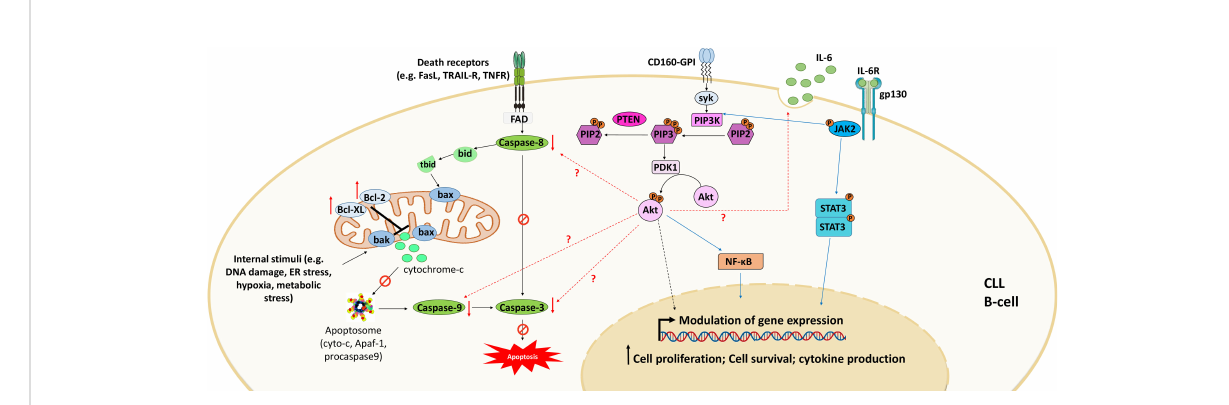
FIGURE 3 CD160 signaling in CLL. Engagement of CD160-GPI via its receptors (MHC-I or HVEM) or monoclonal antibodies leads to activation of the PI3K/ Akt signaling pathway to modulate gene expression. This activation also downregulates the expression of pro-apoptotic proteins and upregulates the expression of anti-apoptotic proteins. Consequently, CD160 dysregulates both intrinsic apoptotic pathways (mediated by internal stimuli) and extrinsic apoptotic pathways (triggered by death receptors such as FasR, TRAIL-R, and TNFR). CD160 also activates the expression of cytokines such as IL-6 that activate STAT3 and NF- k B via the JAK2/PI3K/Akt axis. Adapted from